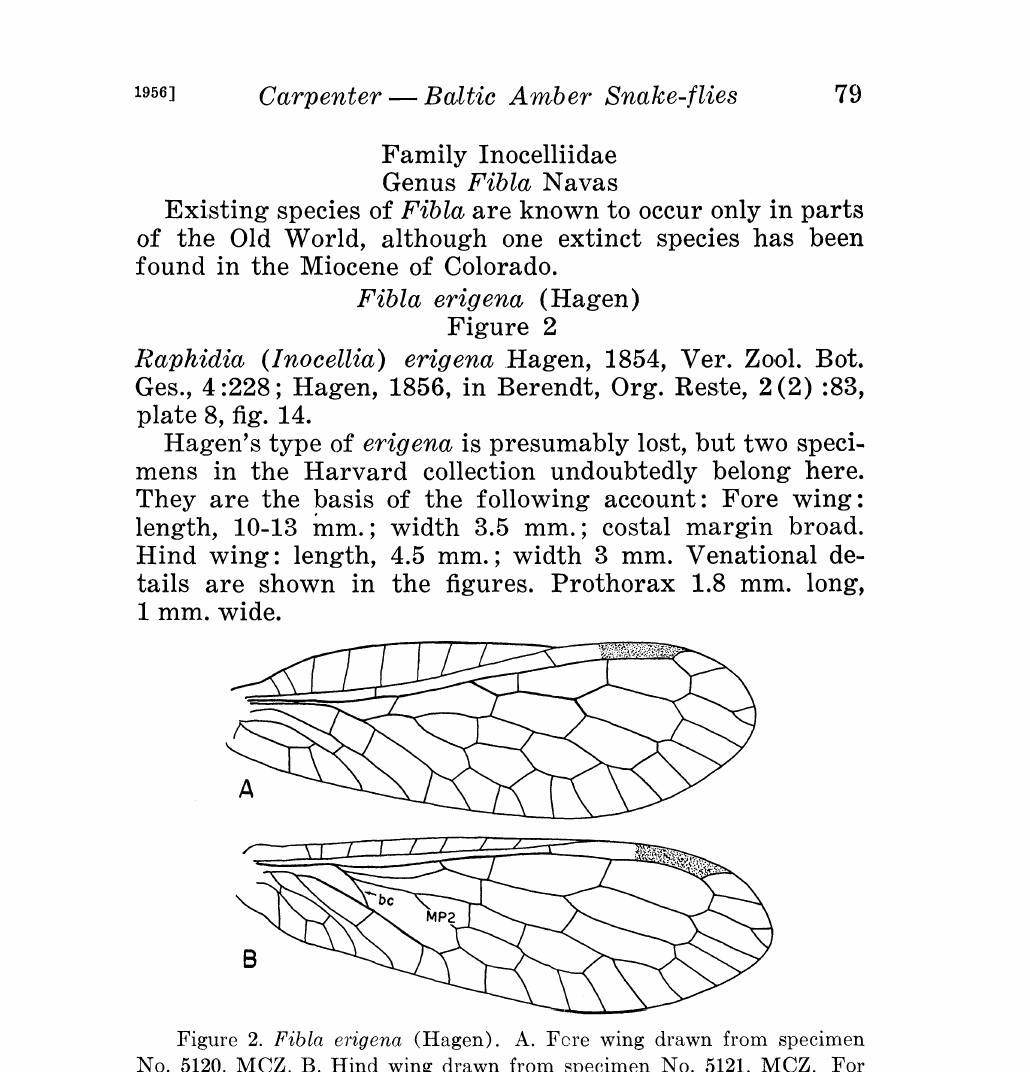
Figure 2. Fibla erigena (Hagen). A. Fore wing drawn from specimen No. 5120, MCZ. B. Hind wing drawn from specimen No. 5121, MCZ. For explanation of bc and MP2, see